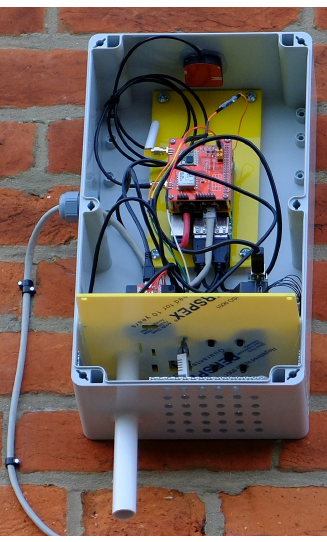
Figure 2. Version 1 of the Air Quality (AQ) Internet of Things (IoT) device, without the enclosure lid; installed on an external